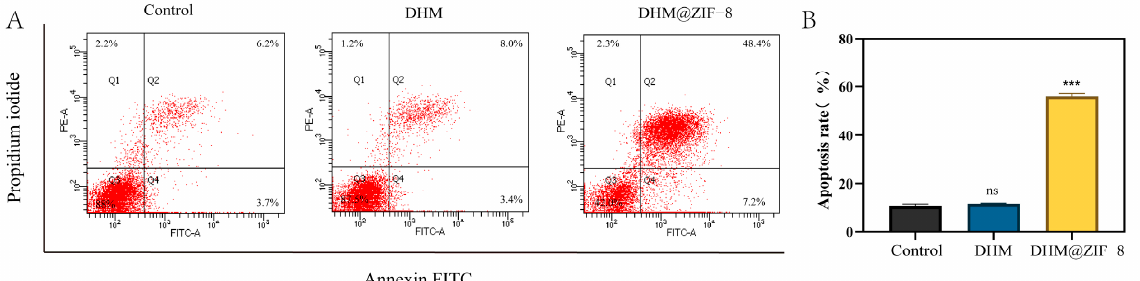
Figure 7. ( A ) Apoptosis after treatment with DHM or DHM@ZIF-8. ( B ) Apoptosis rate. Data are representative of three independent experiments. ns represents no statistical significance, *** p < 0.001 vs. control .